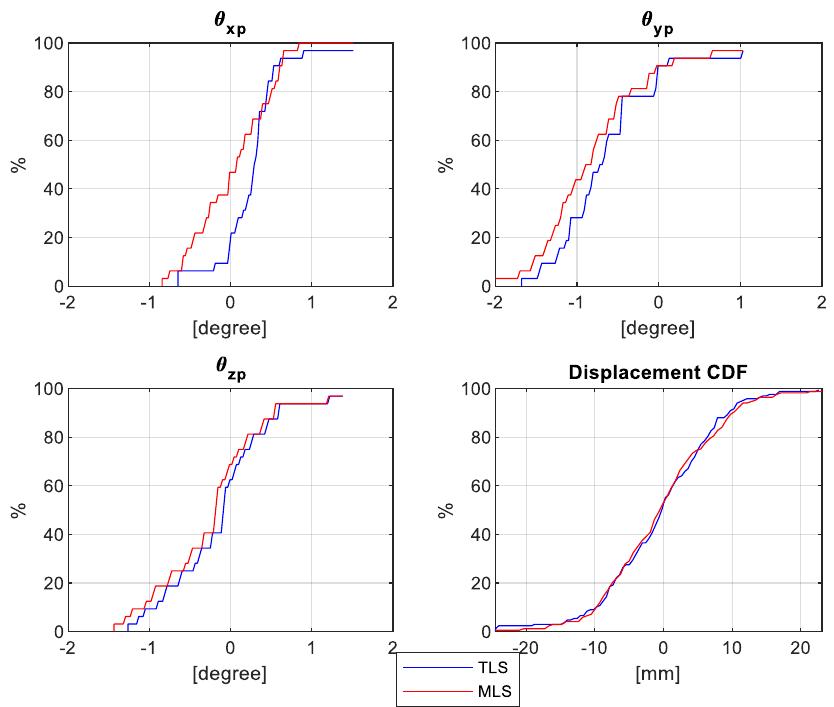
Figure 25. Cumulative Distribution Functions (CDF) for panel 3D orientation and panel-to-panel displacement using TLS (in blue) and MLS (in red) point clouds at Site-1.